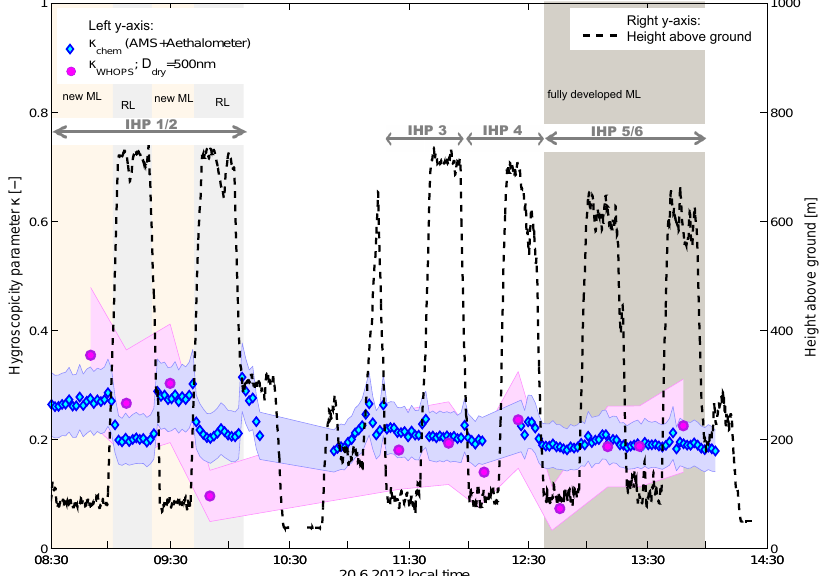
Figure 7. Time series of κ values on 20 June 2012 in Italy. Results from chemical composition ( κ chem ; violet diamonds), and WHOPS for a dry selected diameter of 500nm ( κ WHOPS ; blue points) are shown. The shaded areas depict the measurement accuracy. The dashed line shows the flight altitude. In addition, the times for IHP1/2, IHP3, IHP4 and IHP5/6 are indicated. The coloured areas refer to the layer which was probed at a certain altitude and